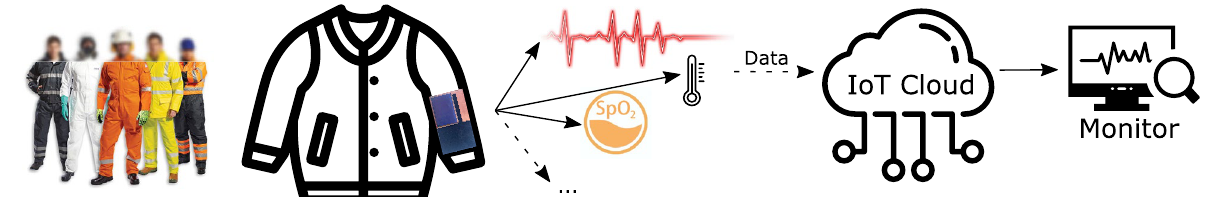
Figure 11. Representative application scenario: Battery-less vital signs (body temperature, blood oxygen level (SpO 2 ) and heart rate) monitoring.